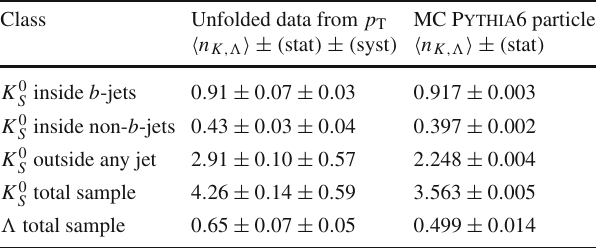
Table 6 K 0 and (cid:3) unfolded (particle-level) average multiplicities per S event ( (cid:8) n K ,(cid:3) (cid:9) ), including statistical and systematic uncertainties,